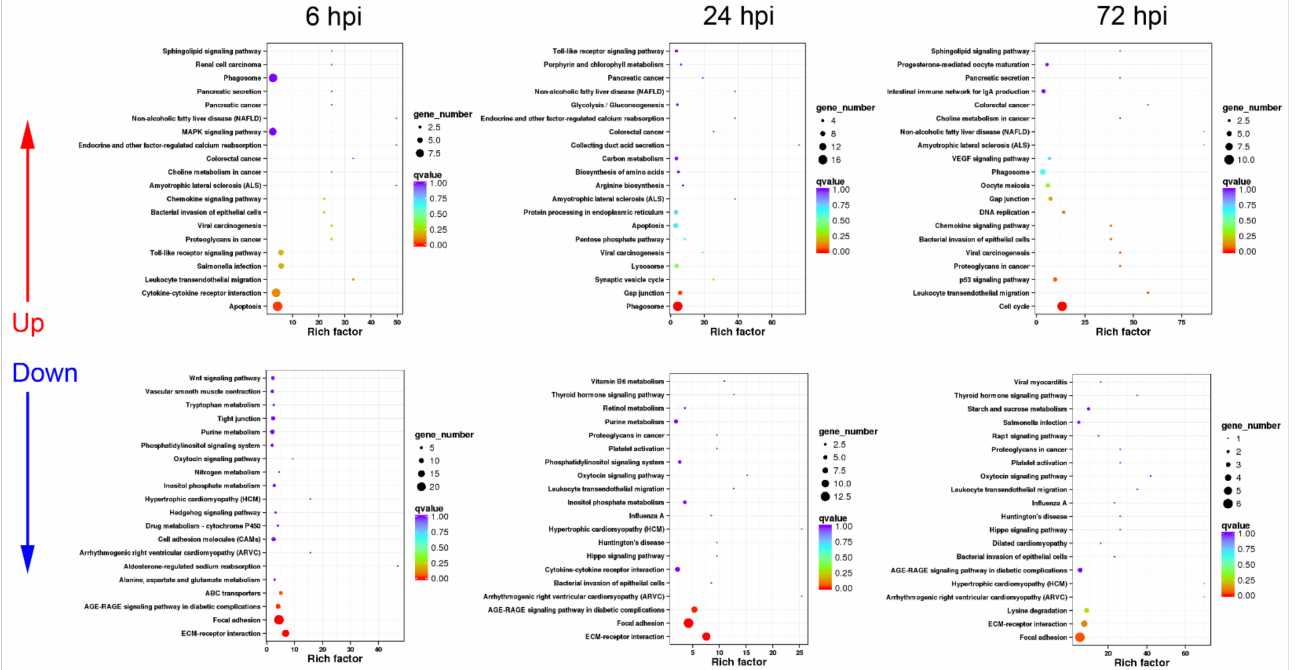
Figure 5. KEGG enrichment analysis in AS group turtles at different time periods. The top 20 KEGG pathways are presented here in the form of scatterplots to show the up-regulated and down-regulated DEGs enriched in spleens from active subgroup turtles at 6, 12, and 72 hpi. The enrichment factor is the ratio between the DEG number and the number of all genes in a certain gene enrichment term. The sizes of the dots on these plots denote the number of DEGs, while colors correspond to the q value